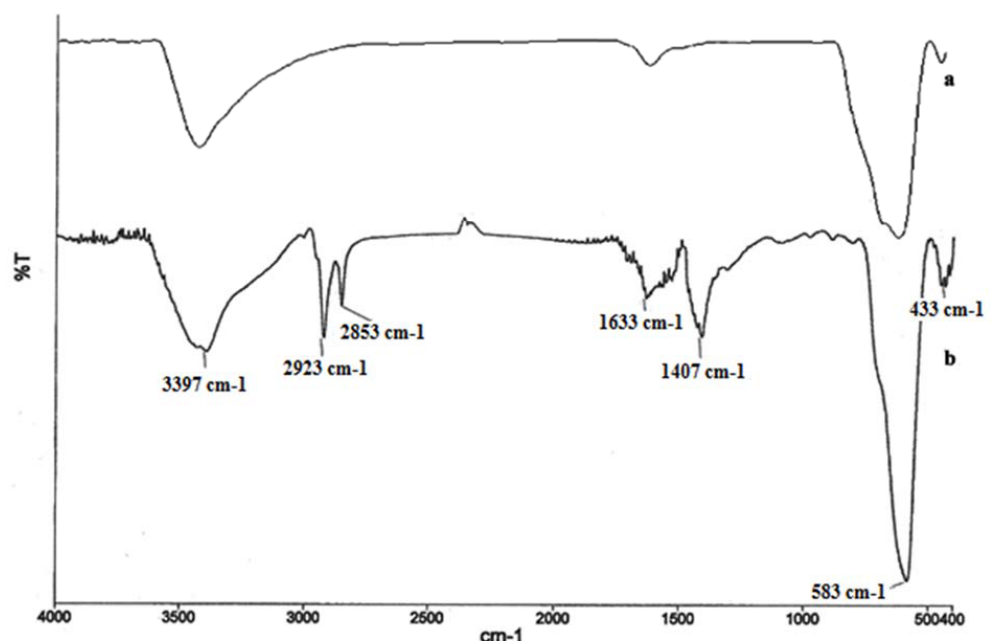
Fig. 3. FT-IR spectra of MNPs (a) and oleic-acid-modified MNPs